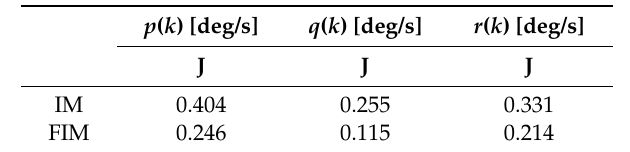
Table 4. Mean value of the cost function J for the four validation flights in case of Conventional IM and FIM approaches.